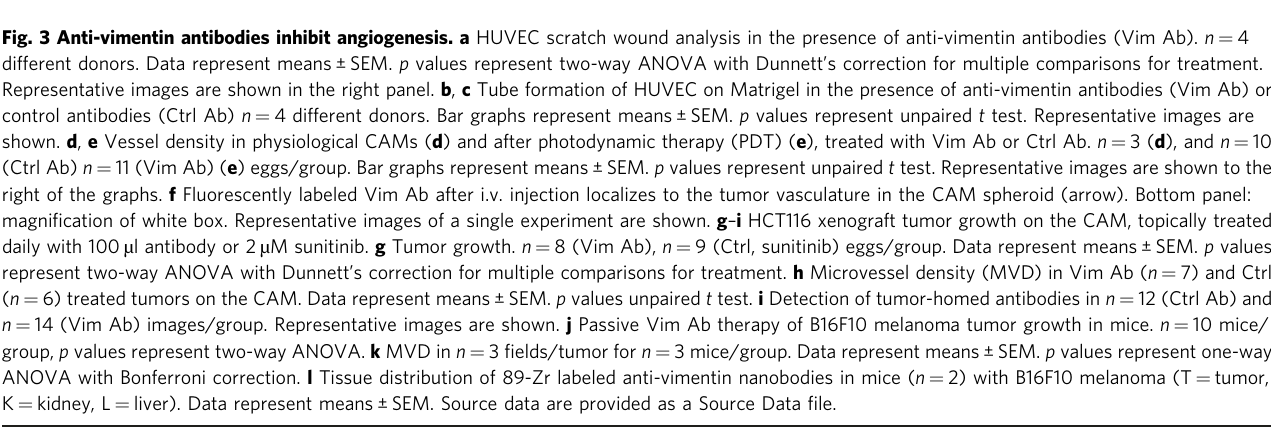
Fig. 3 Anti-vimentin antibodies inhibit angiogenesis. a HUVEC scratch wound analysis in the presence of anti-vimentin antibodies (Vim Ab). n = 4 different donors. Data represent means ± SEM. p values represent two-way ANOVA with Dunnett ’ s correction for multiple comparisons for treatment. Representative images are shown in the right panel. b , c Tube formation of HUVEC on Matrigel in the presence of anti-vimentin antibodies (Vim Ab) or control antibodies (Ctrl Ab) n = 4 different donors. Bar graphs represent means ± SEM. p values represent unpaired t test. Representative images are shown. d , e Vessel density in physiological CAMs ( d ) and after photodynamic therapy (PDT) ( e ), treated with Vim Ab or Ctrl Ab. n = 3 ( d ), and n = 10 (Ctrl Ab) n = 11 (Vim Ab) ( e ) eggs/group. Bar graphs represent means ± SEM. p values represent unpaired t test. Representative images are shown to the right of the graphs. f Fluorescently labeled Vim Ab after i.v. injection localizes to the tumor vasculature in the CAM spheroid (arrow). Bottom panel: magni fi cation of white box. Representative images of a single experiment are shown. g – i HCT116 xenograft tumor growth on the CAM, topically treated daily with 100 µ l antibody or 2 µ M sunitinib. g Tumor growth. n = 8 (Vim Ab), n = 9 (Ctrl, sunitinib) eggs/group. Data represent means ± SEM. p values represent two-way ANOVA with Dunnett ’ s correction for multiple comparisons for treatment. h Microvessel density (MVD) in Vim Ab ( n = 7) and Ctrl ( n = 6) treated tumors on the CAM. Data represent means± SEM. p values unpaired t test. i Detection of tumor-homed antibodies in n = 12 (Ctrl Ab) and n = 14 (Vim Ab) images/group. Representative images are shown. j Passive Vim Ab therapy of B16F10 melanoma tumor growth in mice. n = 10 mice/ group, p values represent two-way ANOVA. k MVD in n = 3 fi elds/tumor for n = 3 mice/group. Data represent means ± SEM. p values represent one-way ANOVA with Bonferroni correction. l Tissue distribution of 89-Zr labeled anti-vimentin nanobodies in mice ( n = 2) with B16F10 melanoma (T = tumor, K = kidney, L = liver). Data represent means ± SEM. Source data are provided as a Source Data fi